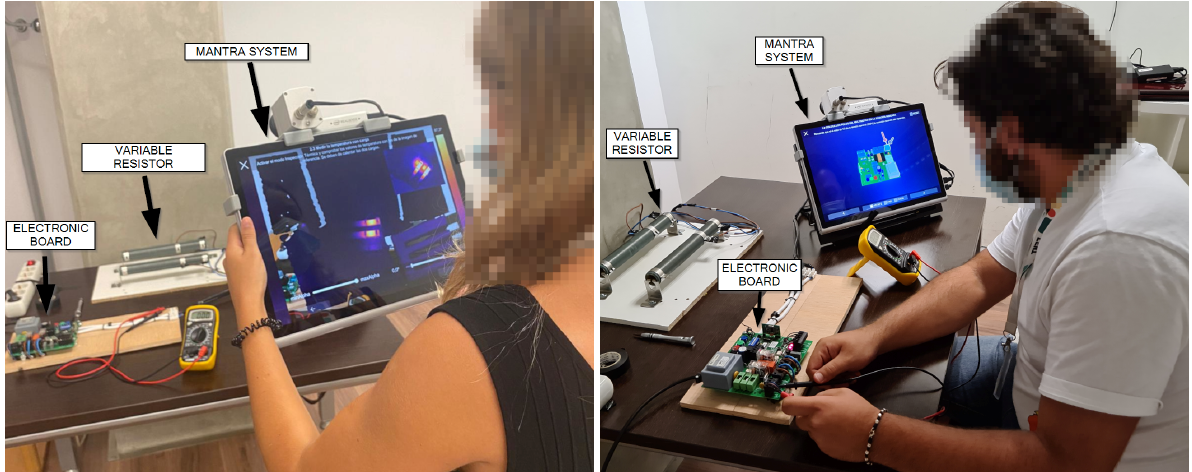
Figure 12. Users testing the MANTRA system.